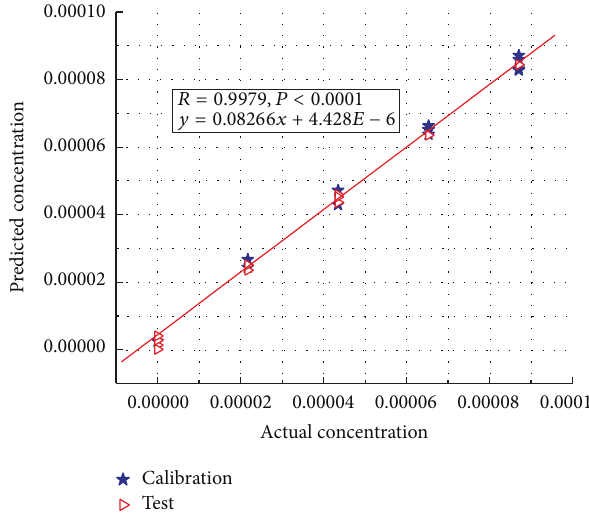
Figure 6: Scatter plot of predicted versus actual concentration for the catechol